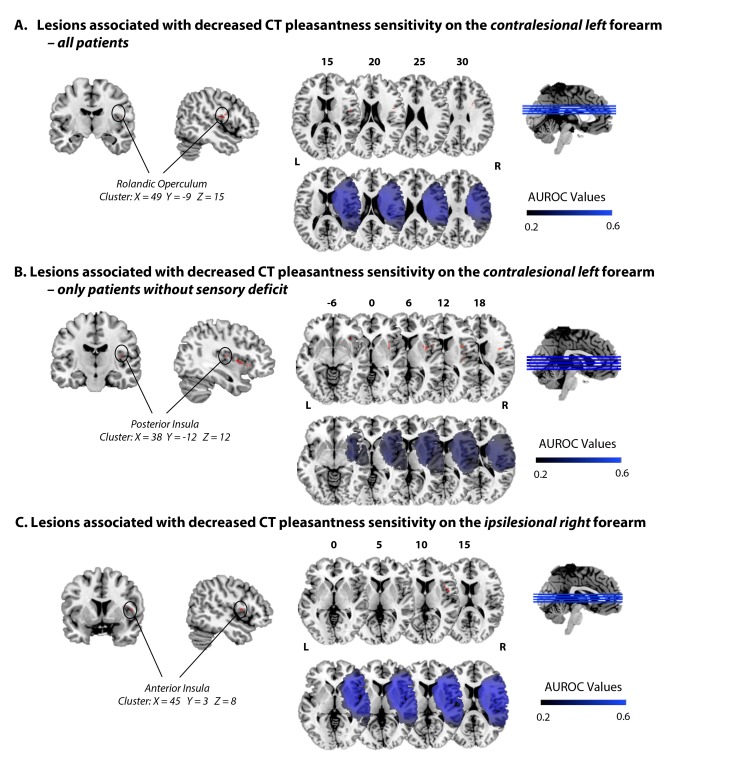
Lesions associated with decreased CT pleasantness sensitivity.(A) Lesions associated with decreased CT pleasantness sensitivity on the contralesional left forearm, in all patients (N = 35). (B) Lesions associated with decreased CT pleasantness sensitivity on the contralesional left forearm, only in patients without sensory deficit on the left (N = 25). (C) Lesions associated with decreased CT pleasantness sensitivity on the ipsilesional right forearm (N = 41). The numbers above the brain slices indicate the corresponding MNI axial coordinates. L = Left; R = Right; The second row represents heat maps of the voxels with power enough to detect significant results, at α = 0.01, FDR-corrected. Different colors represent the area under the ROC curve (AUROC) scores, ranging from 0.2 to 0.6.